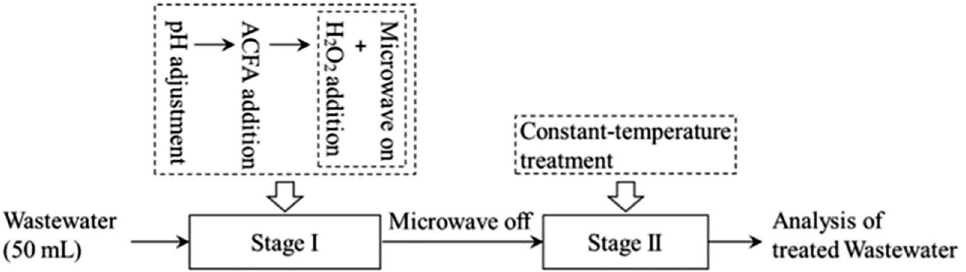
Fig. 14 Treatment of polymer flooding wastewater treatment by H